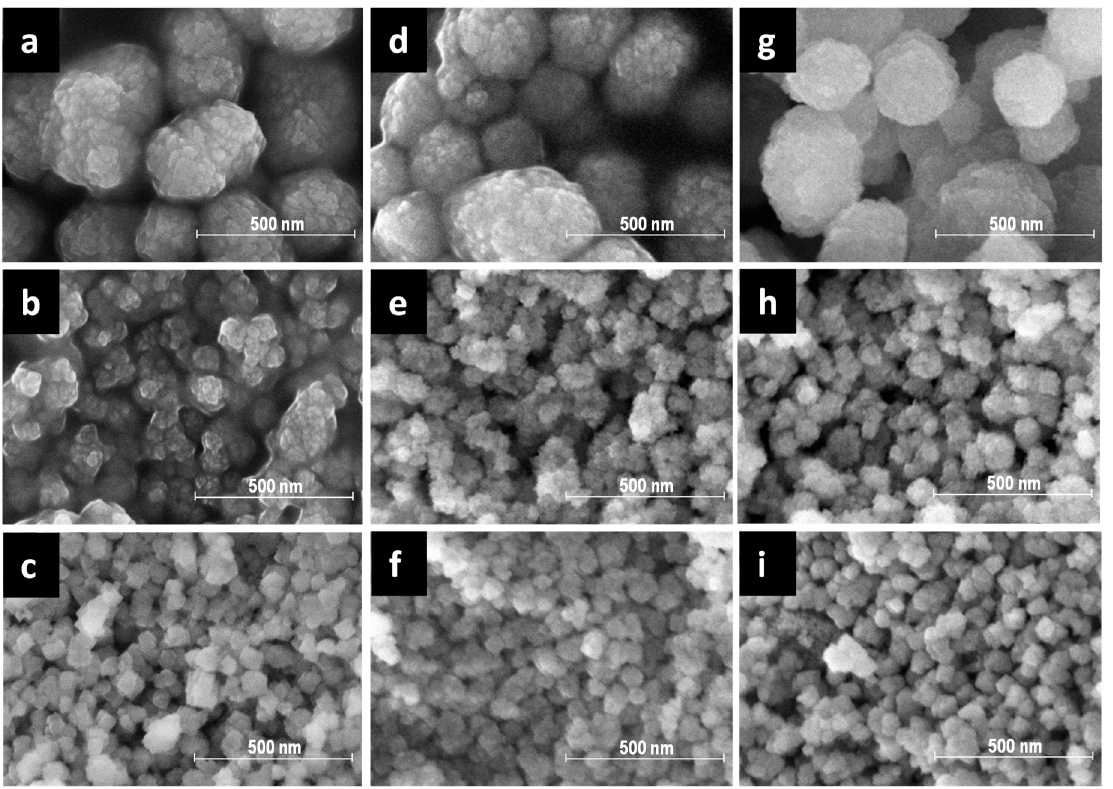
Figure 3. SEM images of B1, B2, and B3 samples as-synthesized ( a – c ), calcined in ammonia ( d – f ) and in air ( g – i ).